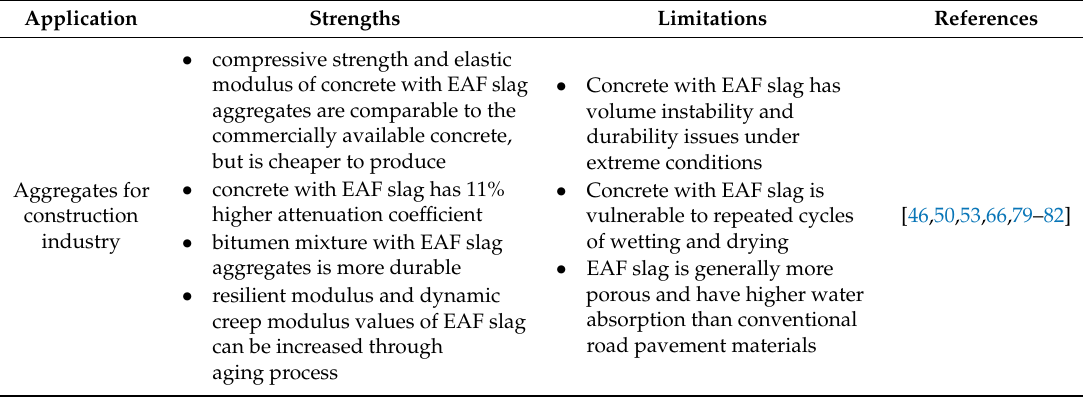
Table 5. Strengths and limitations of incorporating EAF slag in aggregates for the construction